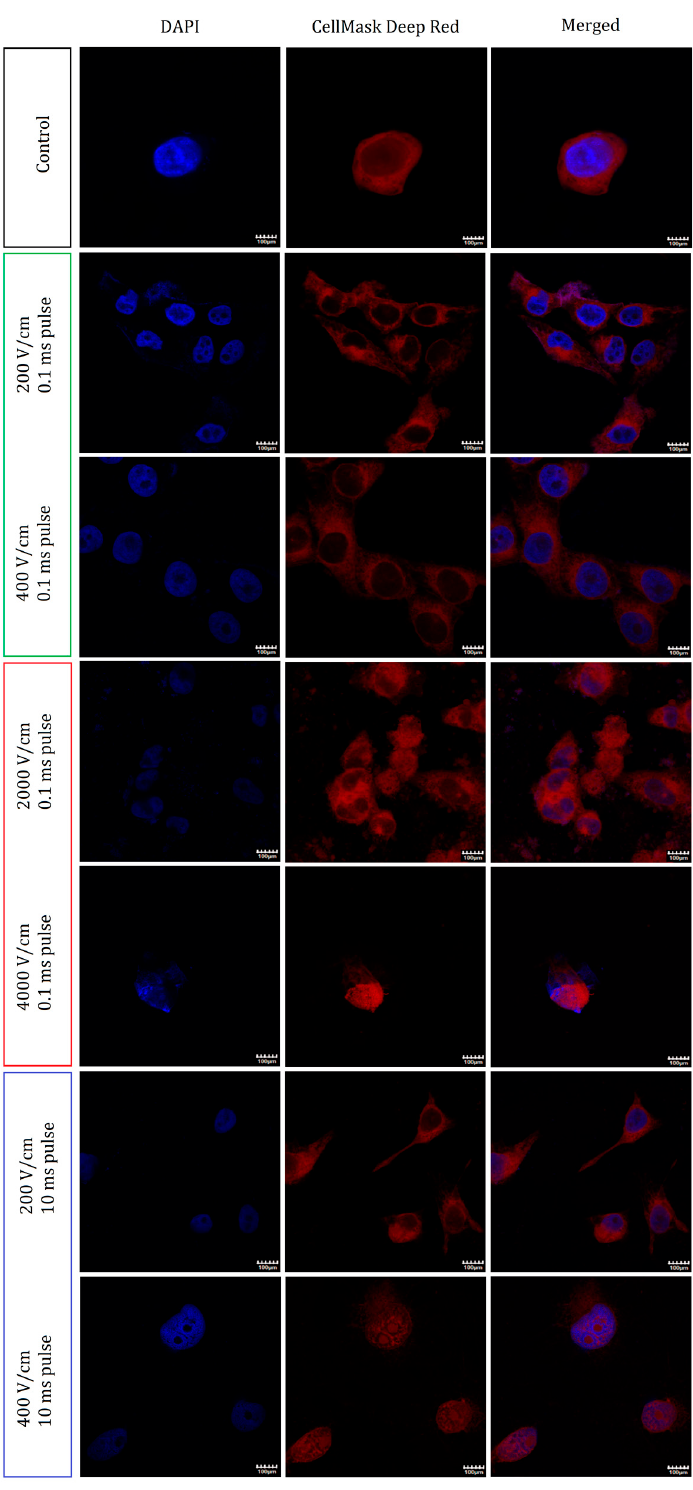
Figure 4. Immunofluorescence staining studies of cells subject to the PEF treatments. The two left columns report the standalone fluorescence of the nuclei and of the cell membranes. On the merged photographs (right panel), both channels are presented together. Each row represents a different electroporation protocol as indicated. The first two present the protocol involving the application of the pulses below EP threshold (200, 400 V/cm, 0.1 ms pulse duration, 8 pulses), next two the increased electric field intensity (IRE, 2–4 kV/cm, 0.1 ms pulse duration, 8 pulses) and the last two the increased pulse duration (200–400 V/cm, 10 ms pulse duration, 8 pulses). Scale bar—100 µ